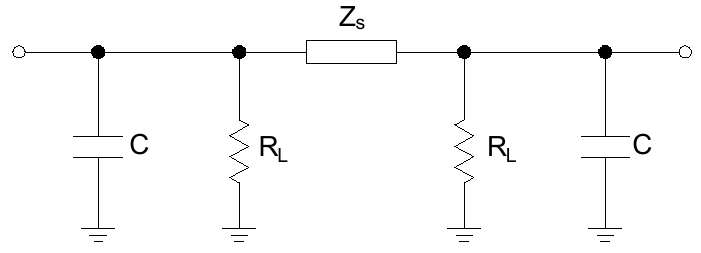
Figure 3. Equivalent Π –circuit of the horizontally buried conductor’s